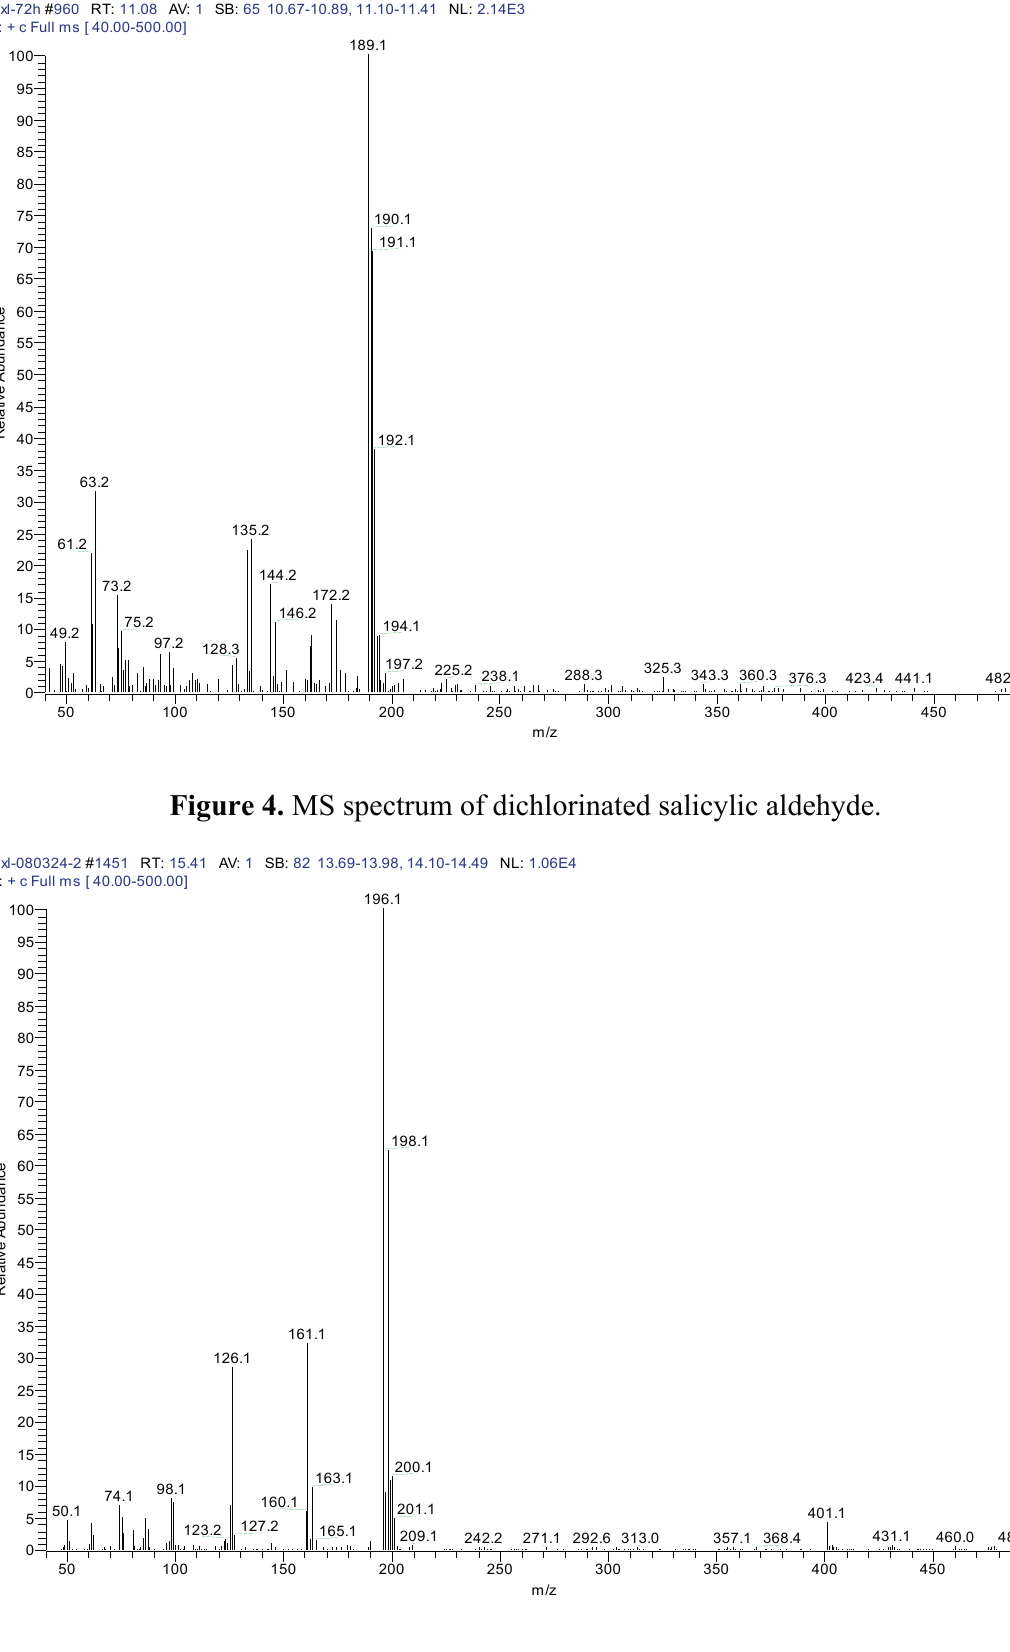
Figure 5. MS spectrum of